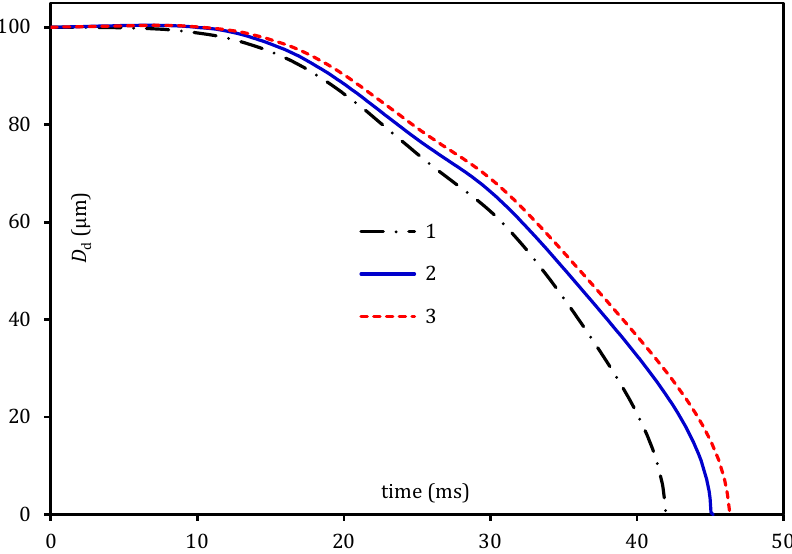
Figure 3. The evolutions of droplet diameter using the three modelling approaches: 1 refers to standard ANSYS Fluent results, with constant properties, 2 refers to ANSYS Fluent results, with in-house properties using UDF and 3 refers to ANSYS Fluent results incorporating the CFSM using UDF.